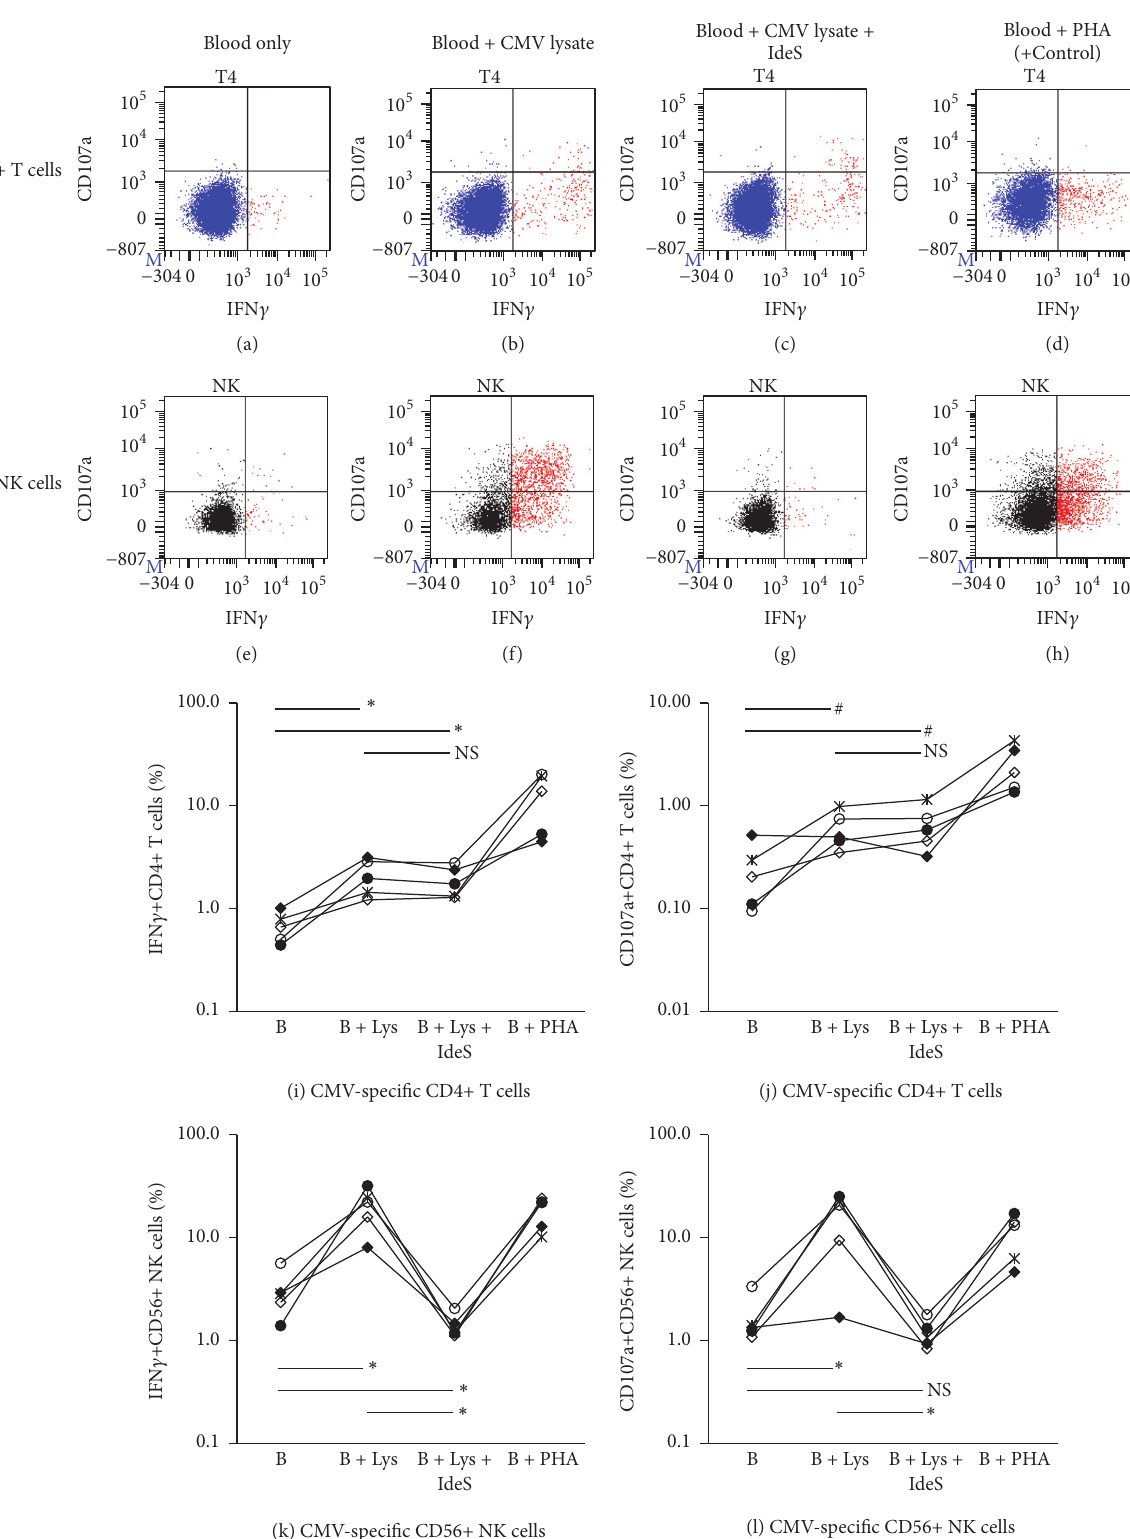
Figure 6: Involvement of anti-CMV IgG in positive reactivity of CMV-Th and CMV-NK cells. Upper (a–h): a typical result of the CMV- Th and CMV-NK assay performed with or without IdeS, IgG-degrading enzyme. Lower (i–l): the summary of 5 sets of experiment results using 5 different normal individuals. Each line with each symbol describes the result from one normal individual. B: blood; Lys: CMV lysate. ∗ 𝑝 < 0.05 , # 𝑝 = 0.05–0.1, and NS: not significant ( 𝑝 ≥ 0.1 ) as assessed by paired 𝑡